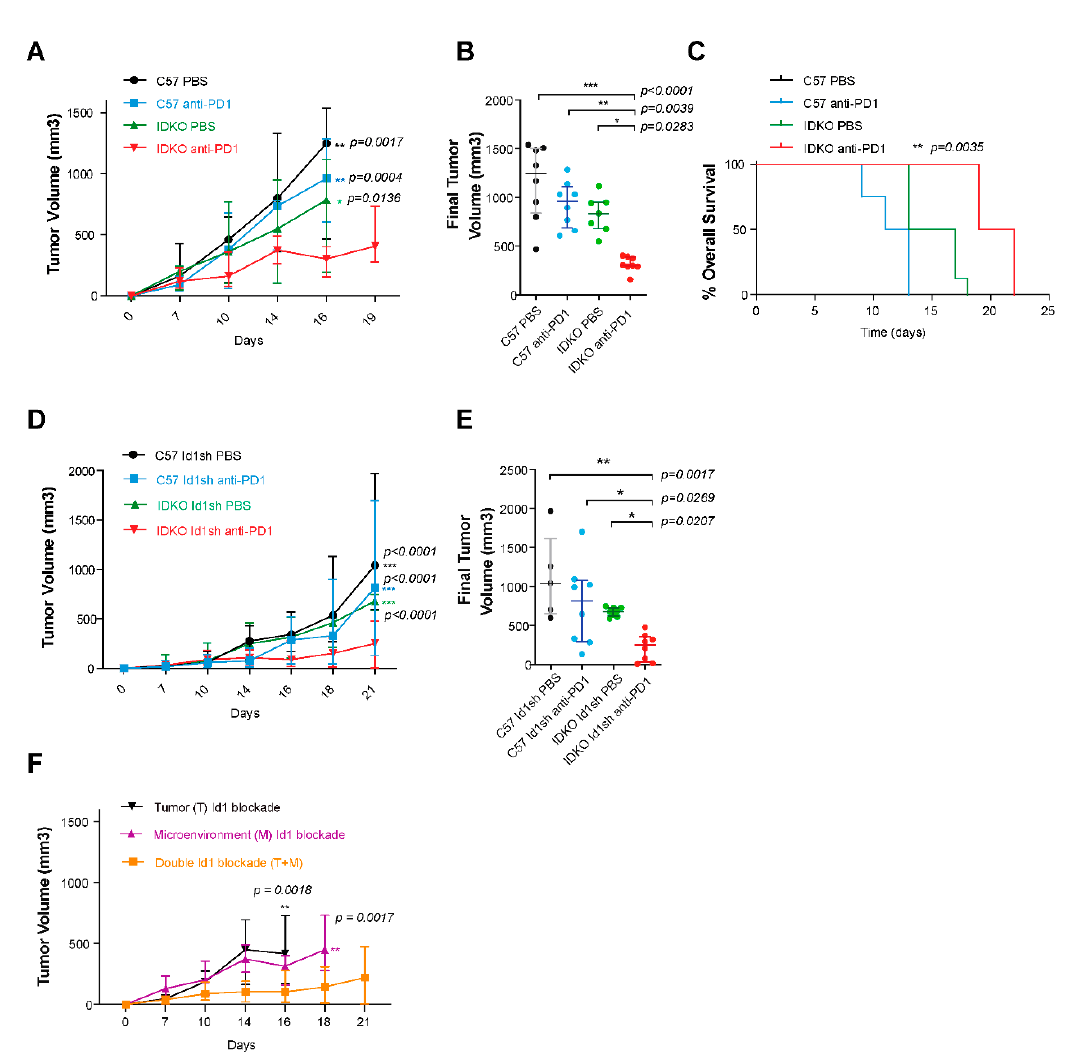
models injected with the LLC cell line (Tumor Id1 blockade (T), Microenvironment Id1 blockade (M) and double Id1 blockade (T + M)) and treated with anti-PD-1 therapy. The data are reported as the median with the interquartile range. * p < 0.05, ** p <